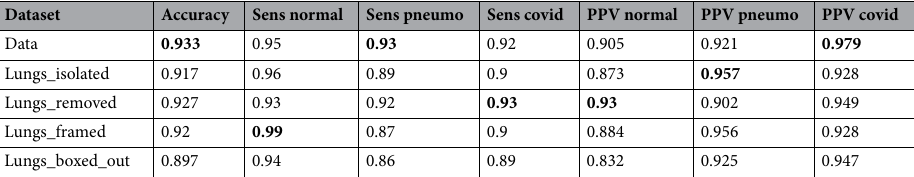
Table 7. Performance metrics using different data preparation strategies classified with pre-trained ResNet-50 model. Bold values correspond to best performance metric for dataset in the same